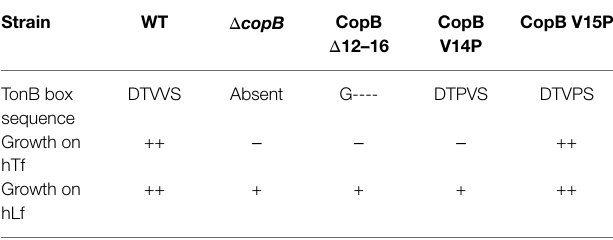
TABLE 5 | Growth phenotype of the strains with mutations in the CopB TonB box